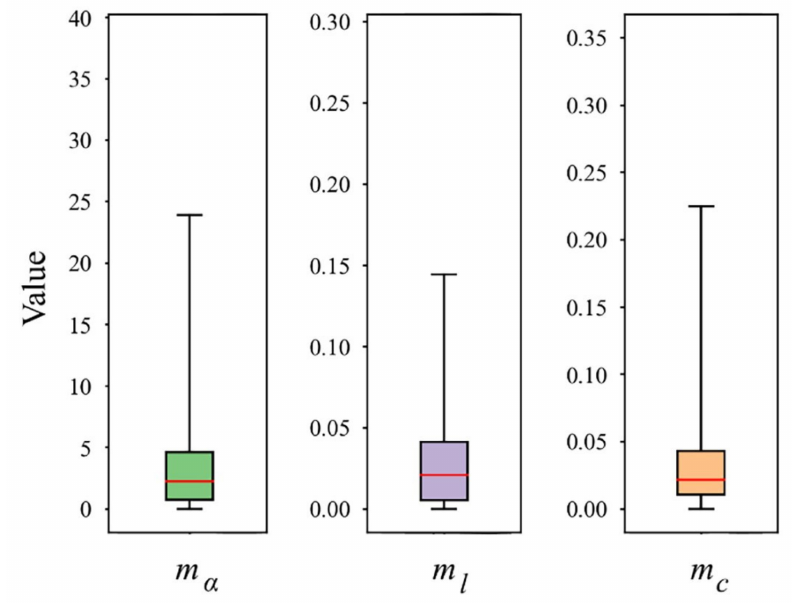
Figure 18. Boxplots of angle, length, and compactness comparison measures for all of the zones with linear